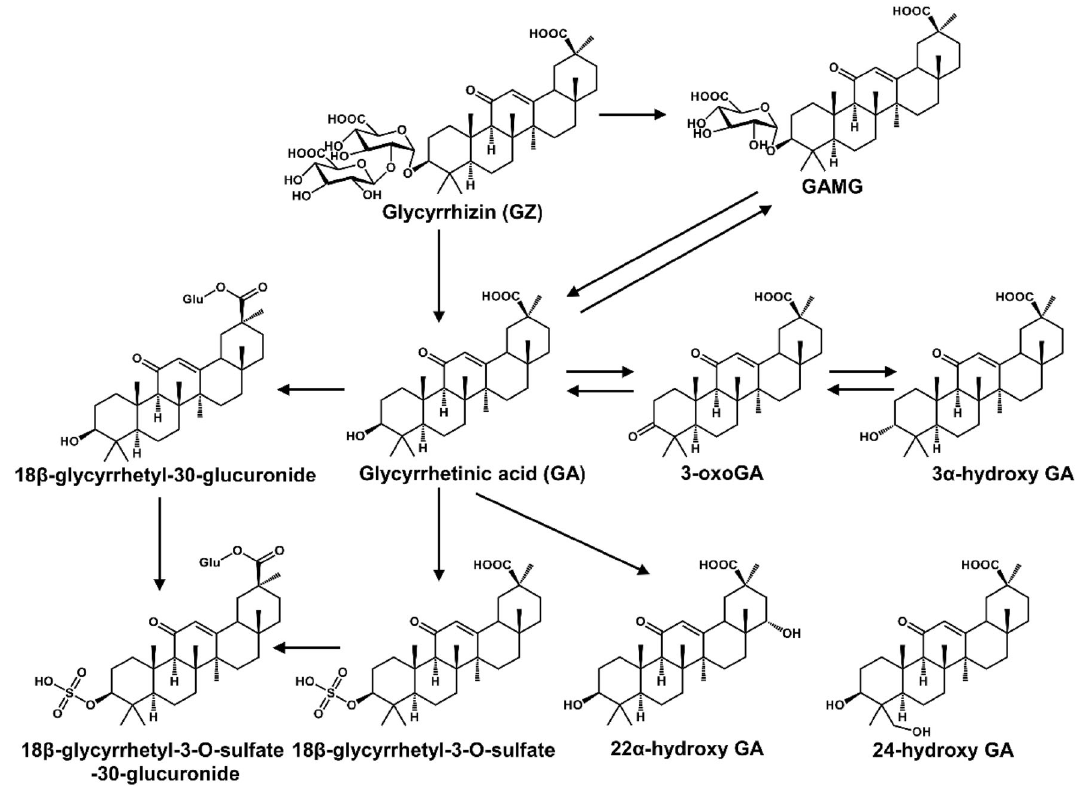
Fig. 1 Metabolic map of glycyrrhizic acid. Reproduced with permission from